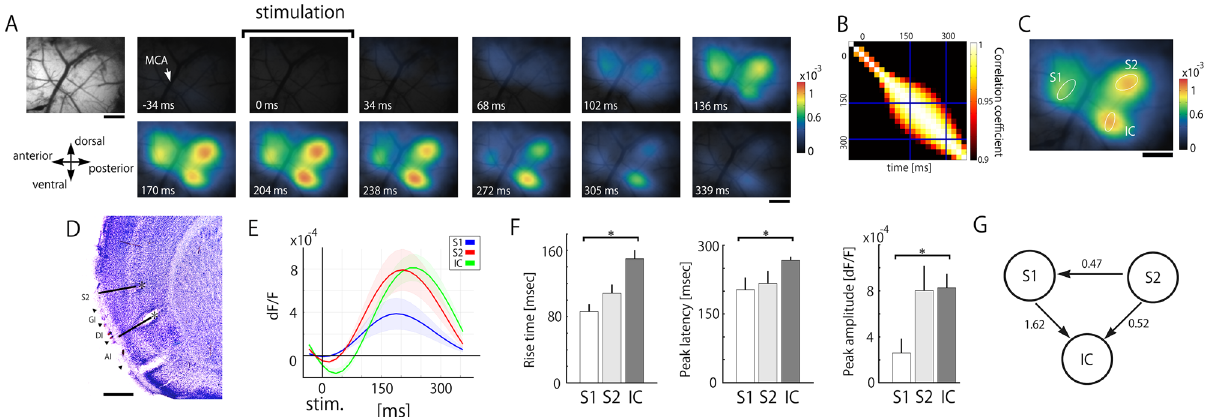
Figure 1. Identification of cortical areas responding to electrical stimulation of the PDL. ( A ) Representative cortical vascular pattern and color-coded cortical activities responding to PDL stimulation (0 ms) revealed by calcium imaging. Responses were obtained by averaging 435 trials. ( B ) A correlation matrix calculated from all pairs of frames. Areas with correlation coefficients (CC) over 0.9 are surrounded by a rectangle, which is defined as the stable response period. ( C ) PDL stimulation-evoked cortical activities obtained by averaging all frames during the stable period. Three cortical areas responsible for PDL stimulation are delineated by ellipses. The centers and major and minor axes for each ellipse are determined by principal component analysis of the local maximum of responses. ( D ) Nissl-stained coronal section. Asterisks indicate the locations of electric lesions applied to the edges of the region of interest. Black lines indicate the directions of the inserted electrodes. S2, granular IC (GI), and dysgranular IC (DI) are located between the two lesions. AI: agranular IC. ( E ) Averaged time courses in S1, S2, and IC. PDL stimulation was applied at 0 ms. ( A )–( C ) and ( E ) are obtained from the same mouse. ( F ) Kinetics of evoked responses, i.e., the rise time (left), latency to the peak (middle), and peak amplitude (right), are compared among S1, S2, and IC. * p < 0.05 (Steel–Dwass test). ( G ) Nonparametric multiplicative regression (NPMR)-based causality estimation of signal time courses across S1, S2, and IC. The arrows indicate a significant direction of causality. A larger value of C NPMR means a stronger causal relationship. Information from S1 and S2 converged into IC. Scale bars in ( A ), ( C ), and ( D ) indicate 500